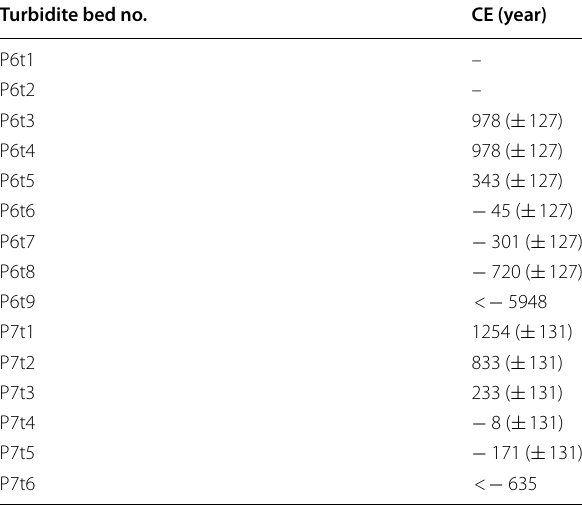
Table 2 Ages of turbidite units based on PSV correlation Turbidite bed no.